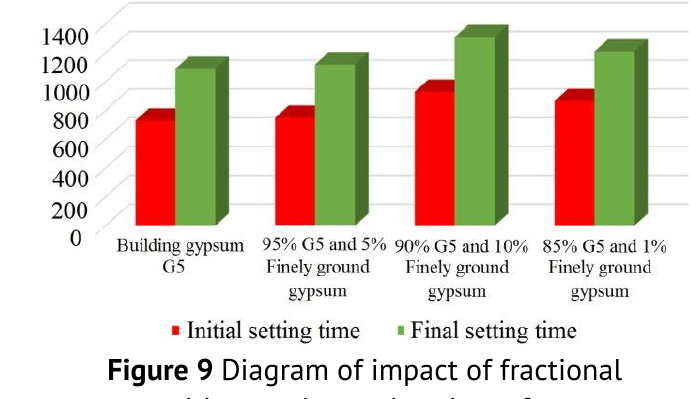
Figure 9 Diagram of impact of fractional composition on the setting time of